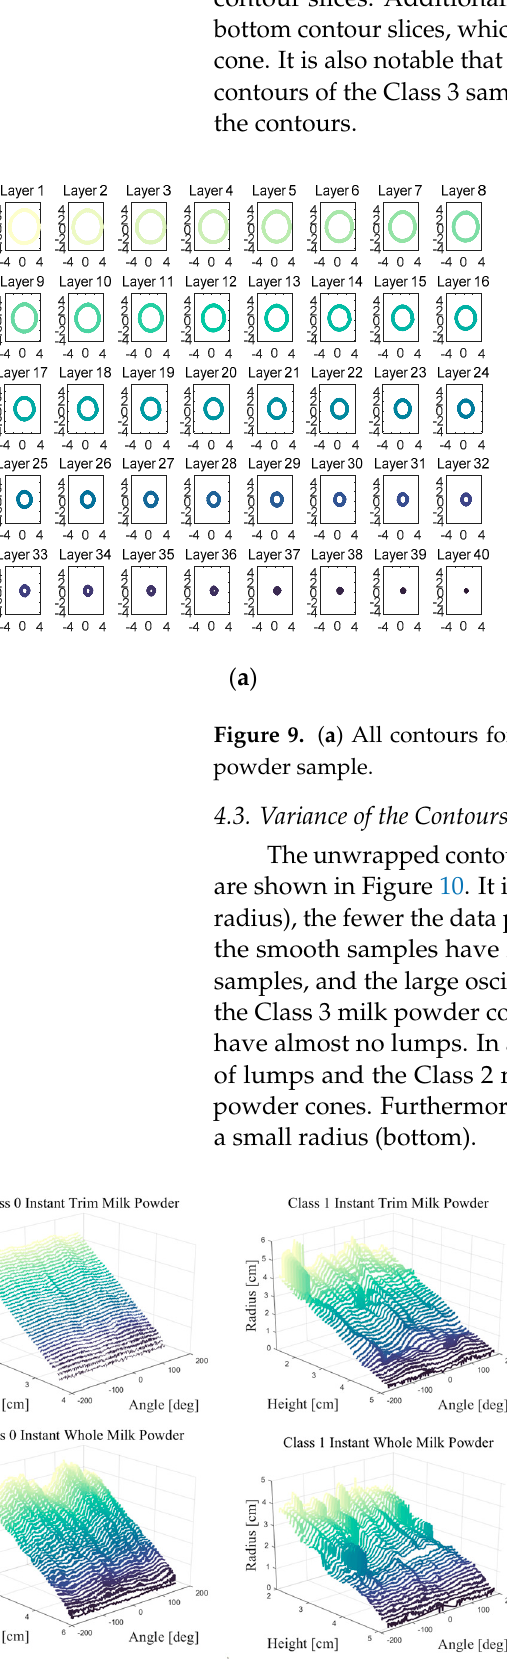
Figure 10. The unwrapped contours of Class 0–3 milk powder samples. The deviations between the contours and the least ‐ squares circles for each layer of Class 0–3 instant whole and trim samples are presented as a linear plot in Figure 11, and Figure 11 also plots the standard deviation for each altitude. A rough surface will have a higher standard deviation while the low standard deviation will be shown in the smooth surface, which is obvious in both the rough and smooth samples. For example, the stand ‐ ard deviations of the Class 0 cones are the lowest, while the standard deviations of the Class 3 cones are the highest. In addition, the Class 1 milk powder cones have a larger standard deviation than the Class 0 cones but a smaller standard deviation than the Class 2 milk powder cones. Additionally, the trends of the standard deviations in each Class milk powder cones are similar. Furthermore, since the lumpiness tends to fall down the milk powder cone, a higher variance is shown in the longer contours nearer the bottom. Figure 11. The deviations and the standard deviation of Class 0–3 instant whole and trim milk pow ‐ der samples. 4.4. Comparing the Frequency Responses Figure 12a,b separately show the results of the contours, deviation, and frequency response of a Class 0 and Class 3 samples. For each sample, the absolute value of the fre ‐ quency response was calculated, and the log of the wavelength against the log of the fre ‐ quency response (which is easier to interpret) was presented in the figures. The linear perimeter distances for each layer (in the deviation plot) are simply computed by using the nominal radius (the following numbers) and the angle around the cone, and it is clear